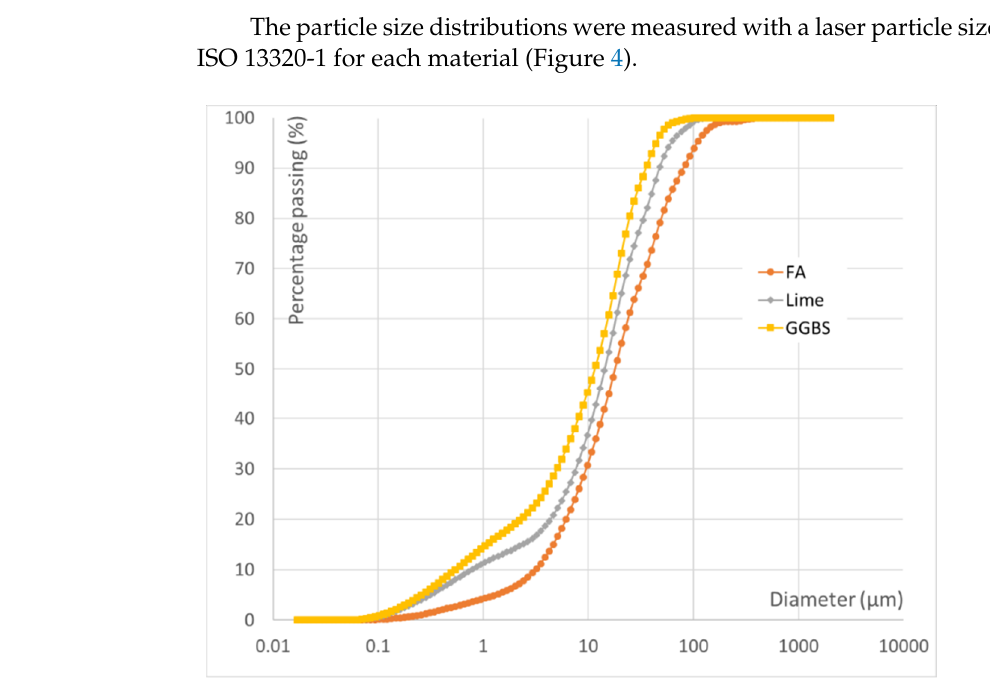
Figure 4. Raw material particle size distribution.